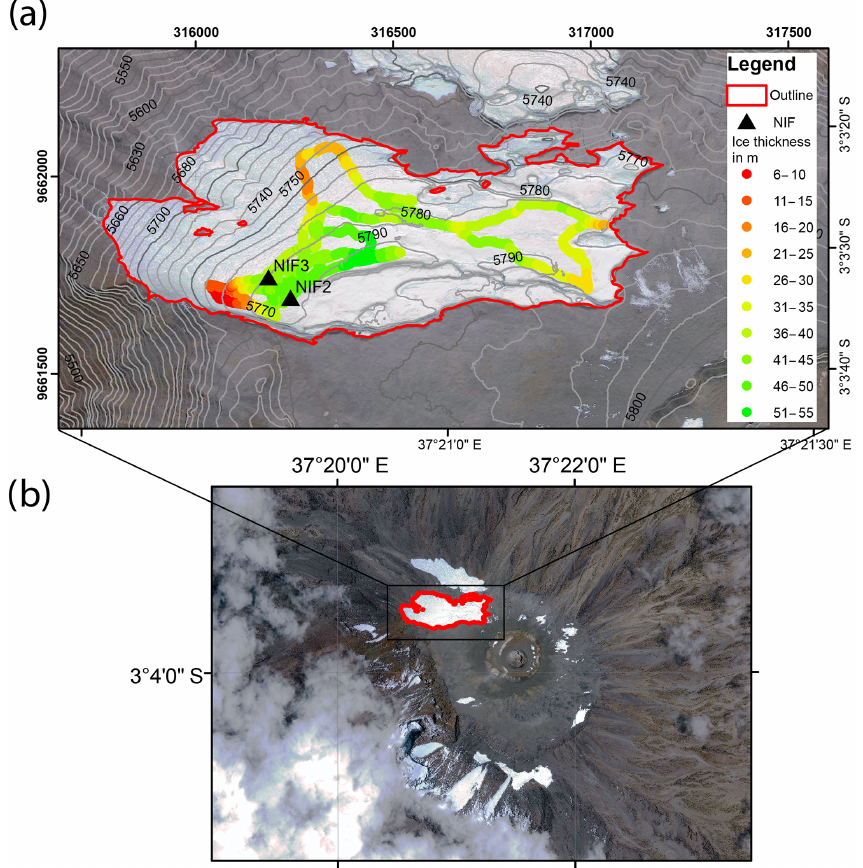
Figure 6. Ice thickness derived from the bed reflection in 100 and 200MHz GPR profiles (a) . The NIF outline is highlighted (red). Shown in (b) is the NIF on an ortho-rectified GeoEye-1 satellite image acquired on 23 October 2012 (Sirguey and Cullen, 2014). Note the crater rim likely extending below the NIF. Coordinates are in UTM